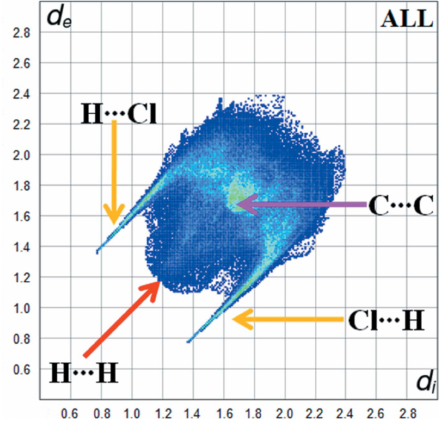
Figure 7 The synthesis of the title compound.